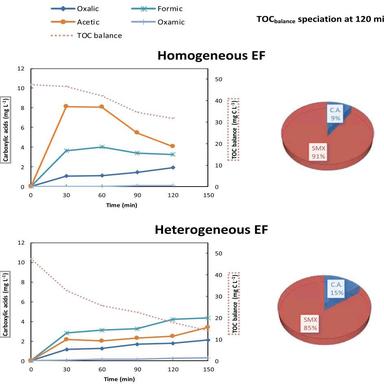
(left) Concentration of carboxylic acids and TOC balance; (right) speciation of TOC balance (fraction of unreacted sulfamethoxazole and carboxylic acids) at 120 min in homogeneous and heterogeneous EF using cathode CQ. Errors are below 3% in all measurements; error bars are not added to the plots for clarity.